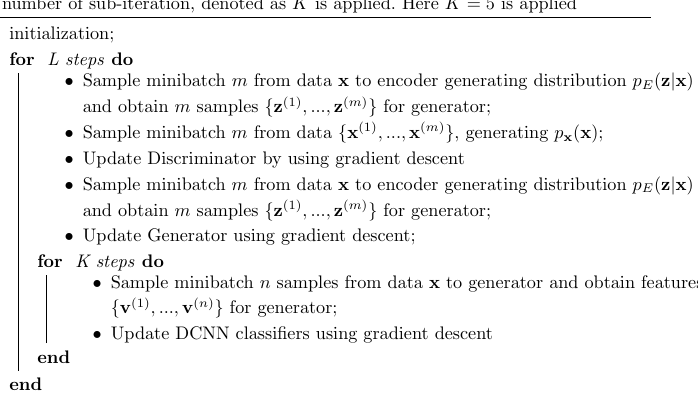
Algorithm 1: Minibatch stochastic gradient descent for EGAN. There